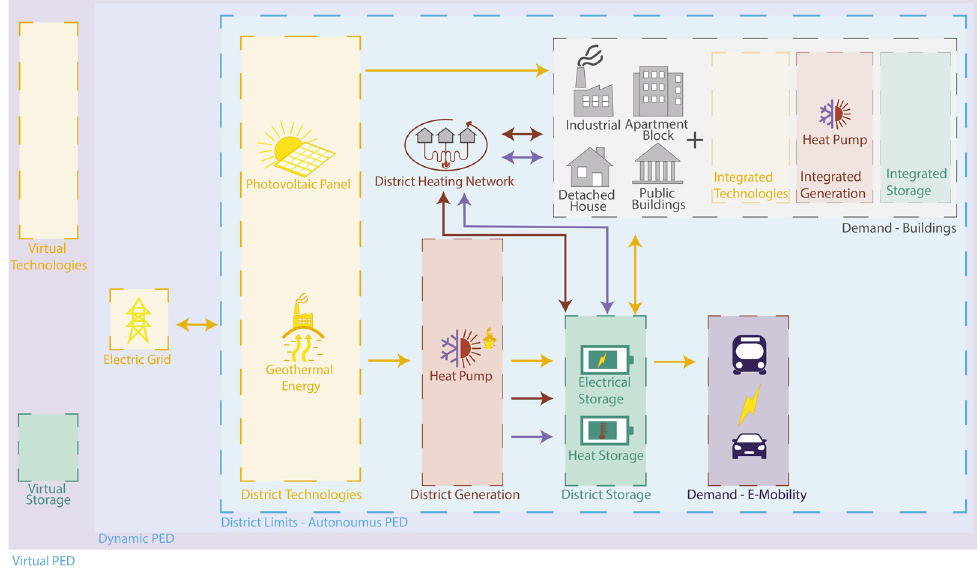
Figure 11. Summary diagrams of the most frequently used technological choices in oceanic climate Cfb.